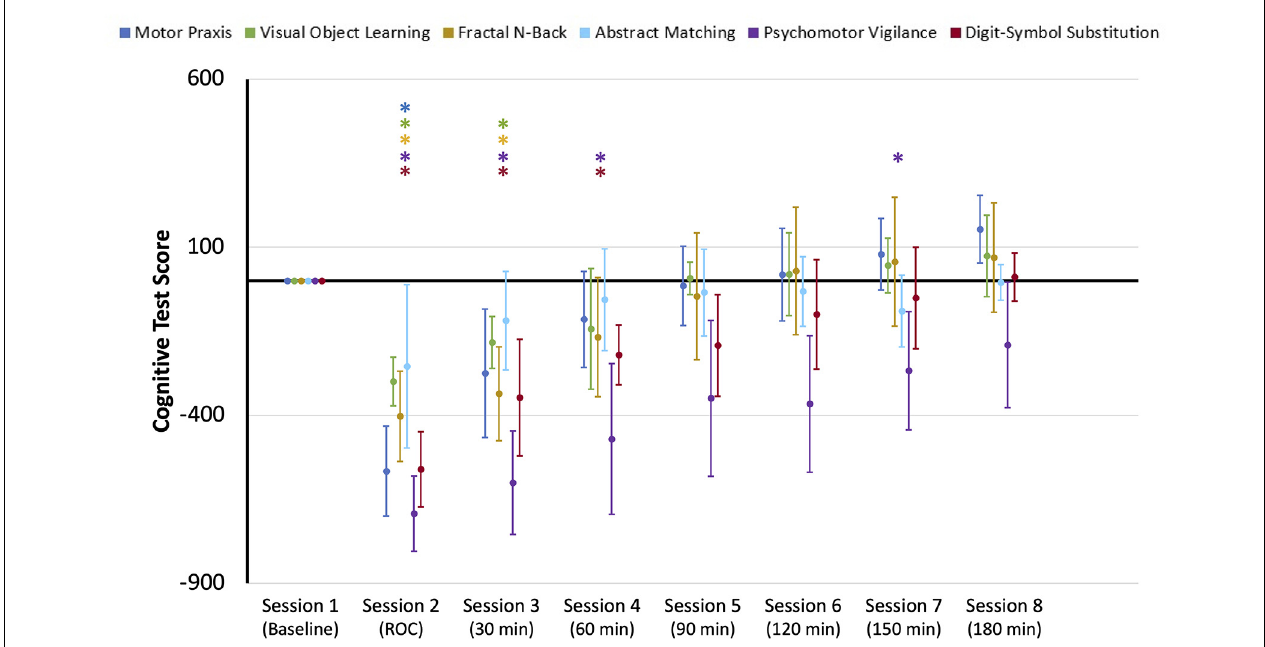
FIGURE 2 | Cognitive test performance scores for the eight sessions of the neurocognitive test battery: baseline, upon recovery of consciousness (ROC), and at six 30-min intervals for 3 h post-ROC. Scores were normalized to baseline performance (0). Error bars indicate standard deviation, and ∗ indicates sessions where scores for each cognitive test were significantly different from baseline.